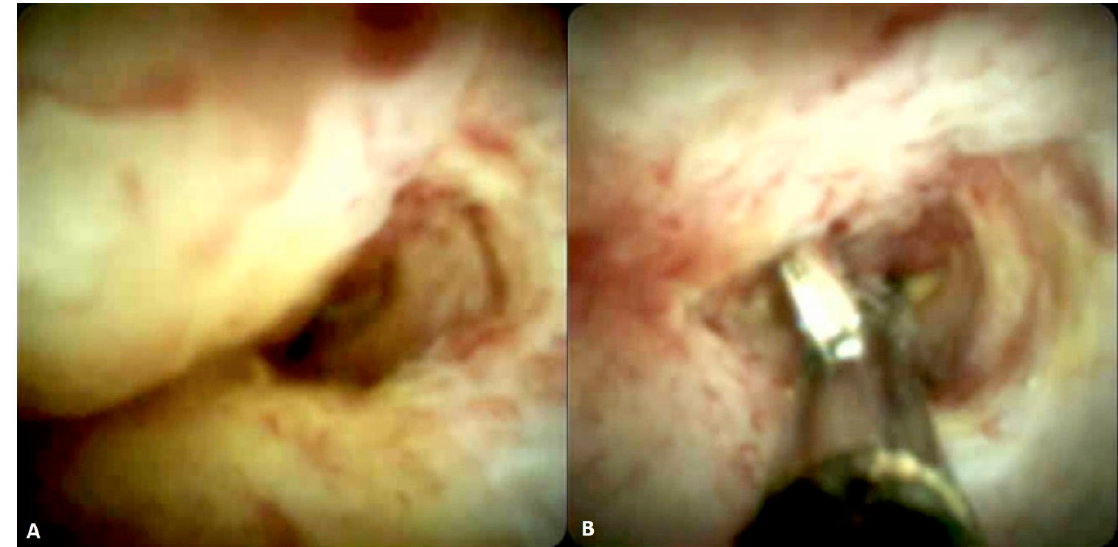
Figure 1. Peroral cholangioscopy of ( A ) a malignant hilar stricture and ( B ) target biopsy under direct visualization.